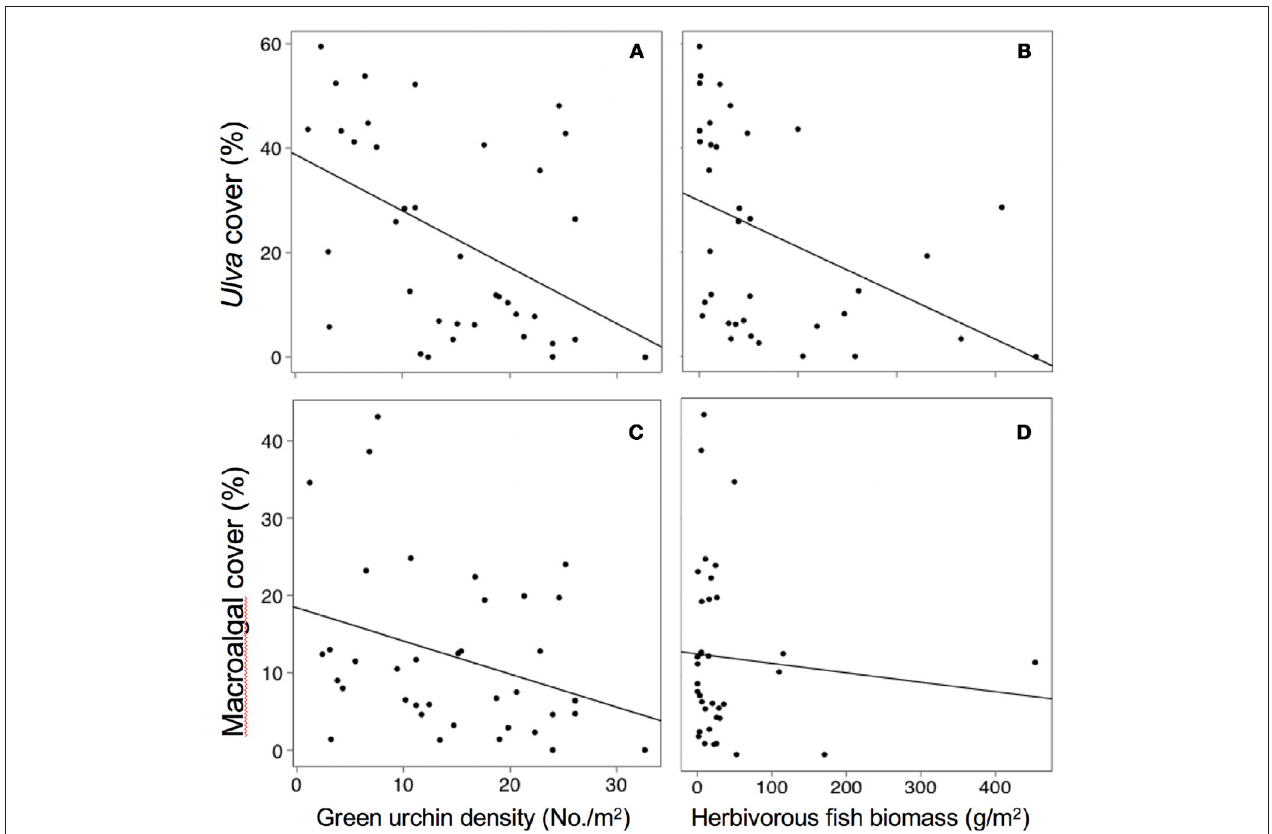
FIGURE 4 | Relationships between herbivore abundance and algal cover. Note in panels C and D “macroalgal cover” does not include Ulva cover. Each point represents a single survey at a given site / time period. (A) P < 0.0001, R 2 = 0.22, (B) P < 0.011, R 2 = 0.18, (C) P < 0.05, R 2 = 0.11, (D) P < 0.45, R 2 = 0.02.